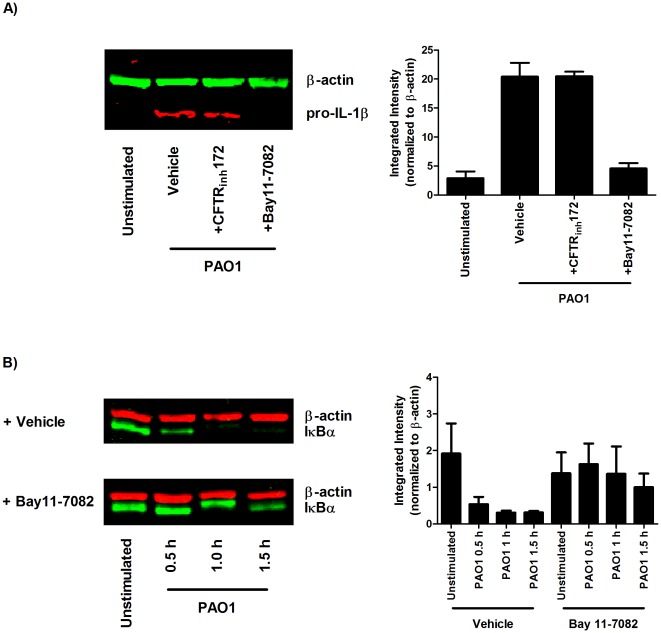
Bay11-7082 inhibits pro-IL-1β production in response to P. aeruginosa.PMA-differentiated THP-1 cells were treated with 10 µM CFTRinh172 or 20 µM Bay11-7082 and harvested after (A) 4 hours (n = 3) or (B) 0.5, 1, and 1.5 hours (n = 3) stimulation with PAO1. One representative blot is shown with a graph of the averaged fluorescence intensity values over 3 experiments.